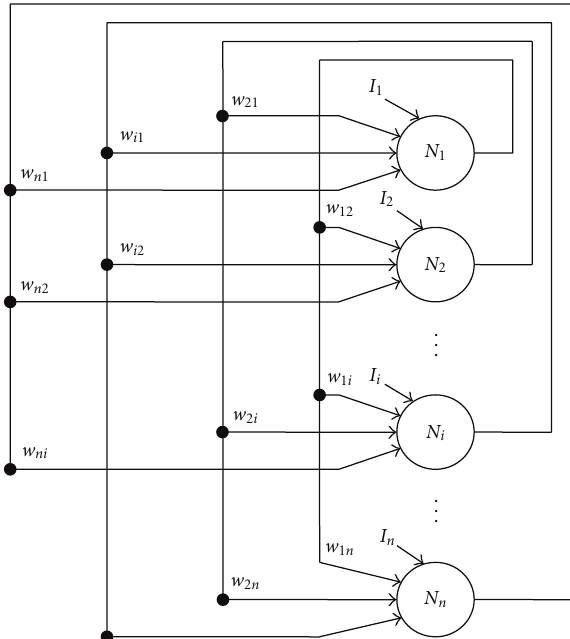
Figure 4: Discrete Hopfield neural